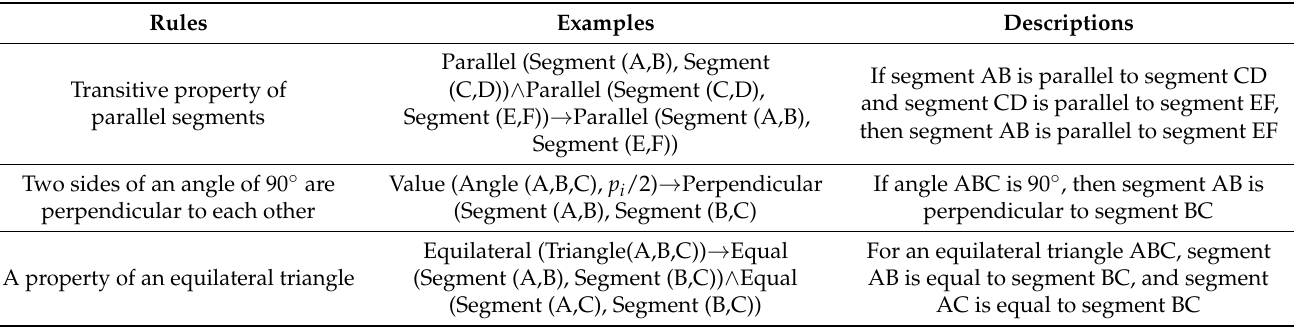
Table 3. Examples of